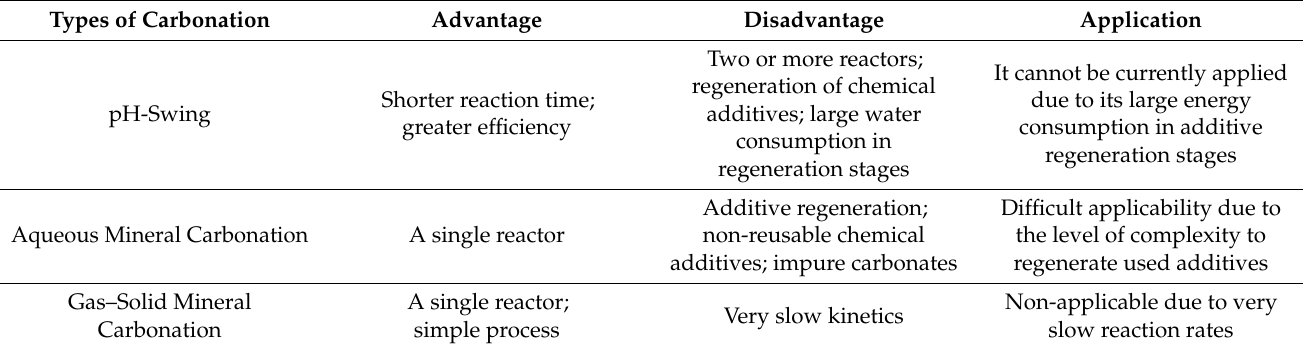
Table 1. Comparison of different types of mineral carbonation